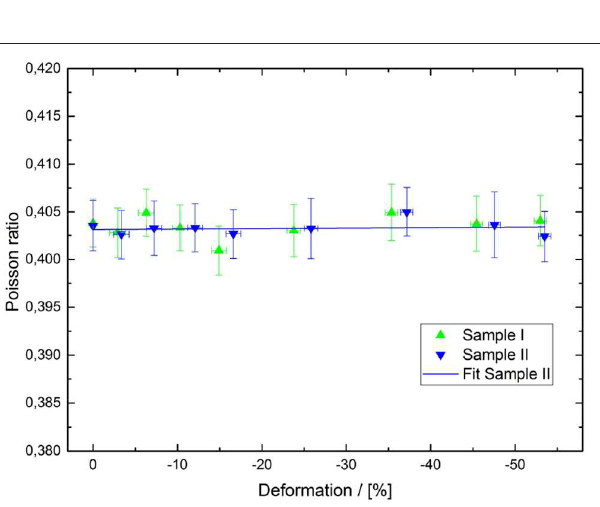
FIGURE 9 | Evolution of the Poisson’s ratio in Pd 40 Ni 40 P 20 during cold-rolling. The error bars represent the standard deviation of a set of 10 measurements. Sample I and sample II are different casts of Pd 40 Ni 40 P 20 metallic glass to showcase the reproducibility of this experiment.